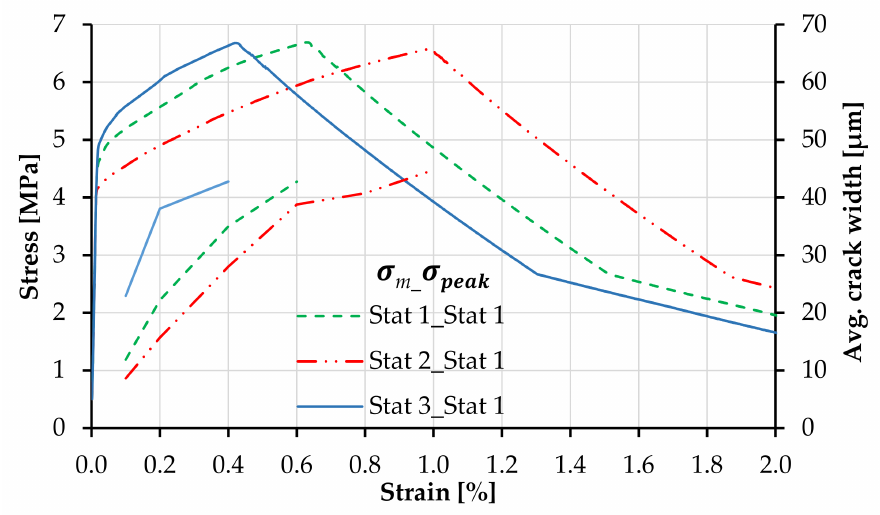
Figure 8. Tensile stress–strain curves corresponding to plain SHCC with different distribution functions of matrix strength and constant distribution function of tensile